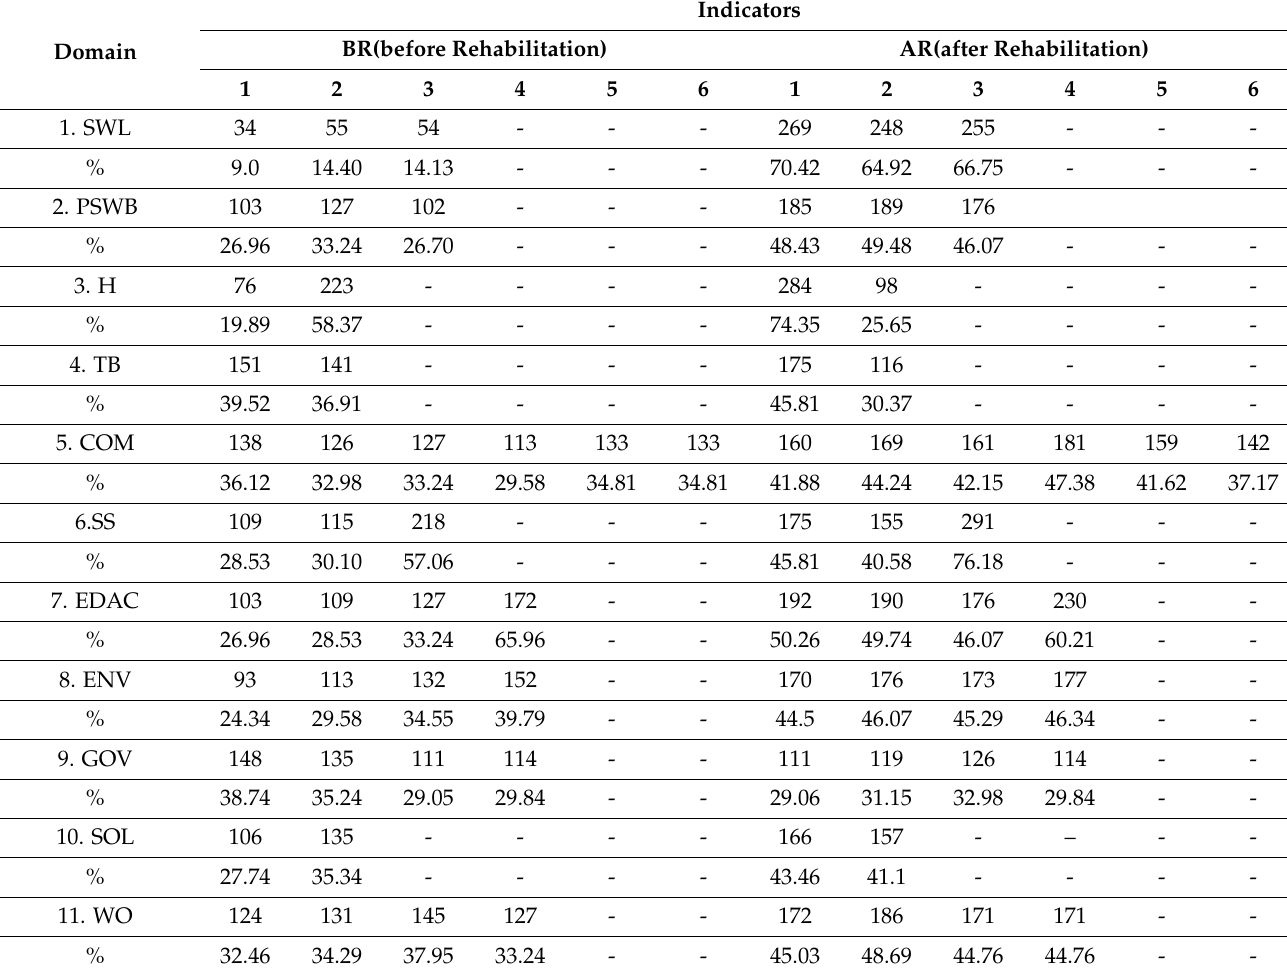
Table 2. Frequency and percentage of the happy people BR and AR. Source: Compiled by the researchers.